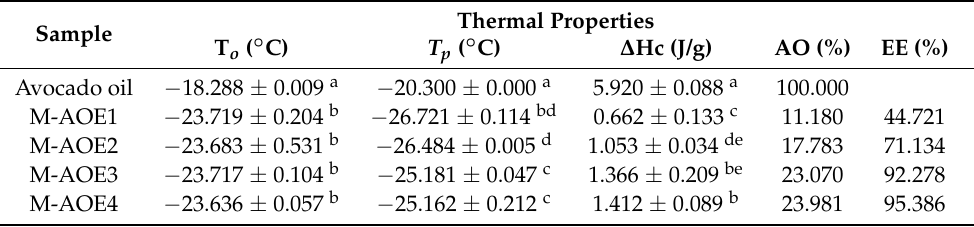
Table 4. Thermal properties of avocado oil powders.